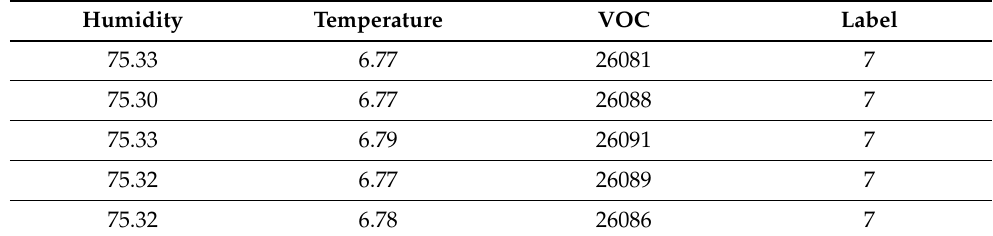
Table 1. Example Subset VOC